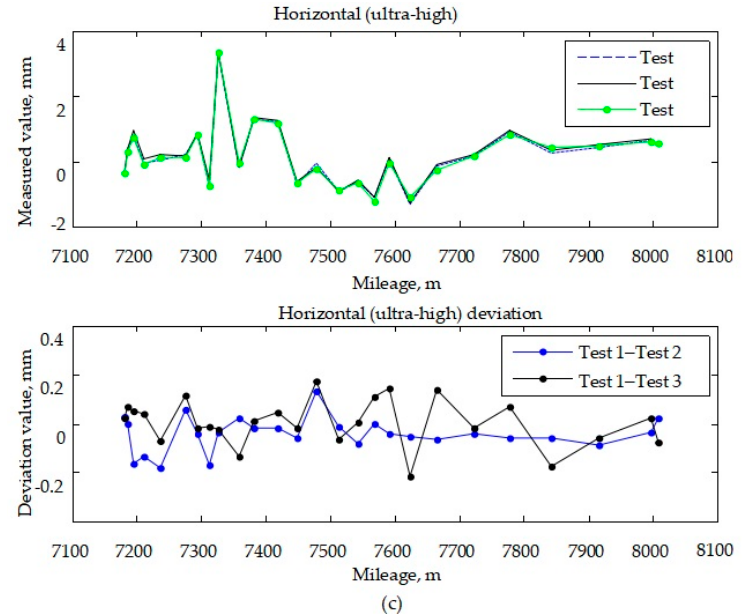
Figure 7. Repeatability comparison showing data from three experimental replicates for track geometry parameter measurements of test lines: ( a ) track direction; ( b ) high and low; ( c ) horizontal (ultra-high).